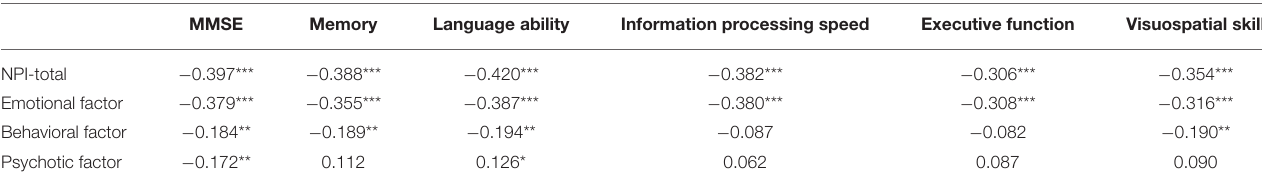
TABLE 3 | Correlations between NPS and cognitive function in all